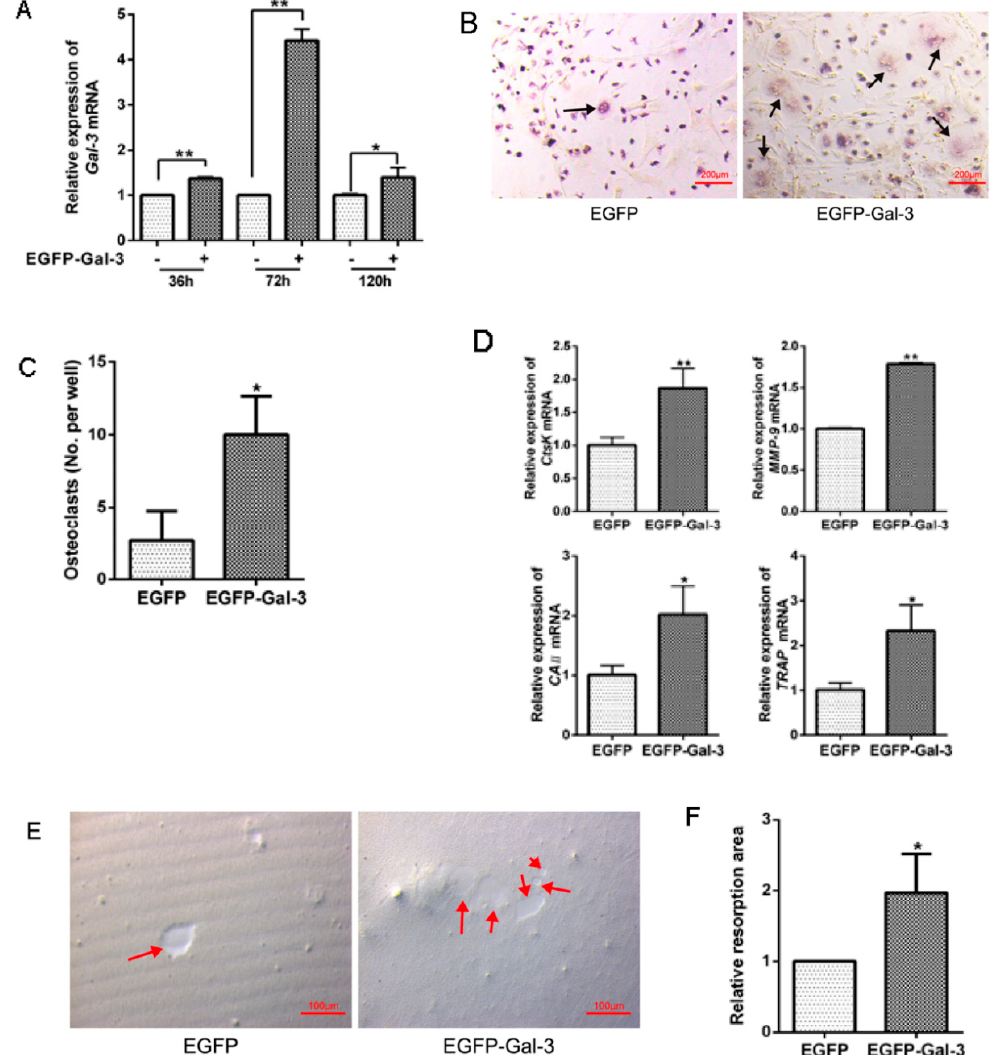
Figure 5. Gal-3 overexpression in BMSCs promotes osteoclastogenesis and bone resorption. ( A ) BMSCs were seeded for 12 h before transfection with EGFP-Gal-3 or EGFP empty plasmid for 10 h before being cultured in normal α -MEM for 36, 72, or 120 h. Quantitative RT-PCR was used to quantitate the expression of Gal-3 mRNA ( n = 3 per group). ( B , C ) After Gal-3 was overexpressed in BMSCs, BMSCs and BMMs were co-cultured for 5 d. An EGFP empty control was set up. Ten fields were randomly selected. The number of TRAP-positive multinucleated OCs (black arrows) was determined. Bar = 200 µ m. ( D ) After Gal-3 was overexpressed in BMSCs, BMSCs were co-cultured with BMMs. Quantitative RT-PCR was used to quantitate the mRNA expression of OC marker genes ( CtsK , CAII, MMP-9 , and TRAP ) ( n = 3 per group). ( E , F ) After BMSCs were seeded in 96-well bone resorption culture plates and Gal-3 was overexpressed, BMSCs and BMMs were co-cultured for 5 days. An inverted microscope was used for observation of 10 randomly selected fields. Image-Pro Plus 6.0 software was used to analyze the area of bone resorption pits (red arrows). Bar = 100 μ m. (Graph bars show mean ± SD. * p < 0.05 and ** p < 0.01 show significant difference compared with the control group).